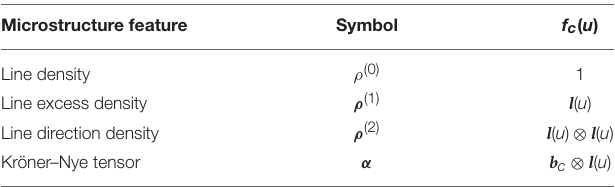
TABLE 1 | Features extracted from the dislocation microstructures following Equation (6). Microstructure